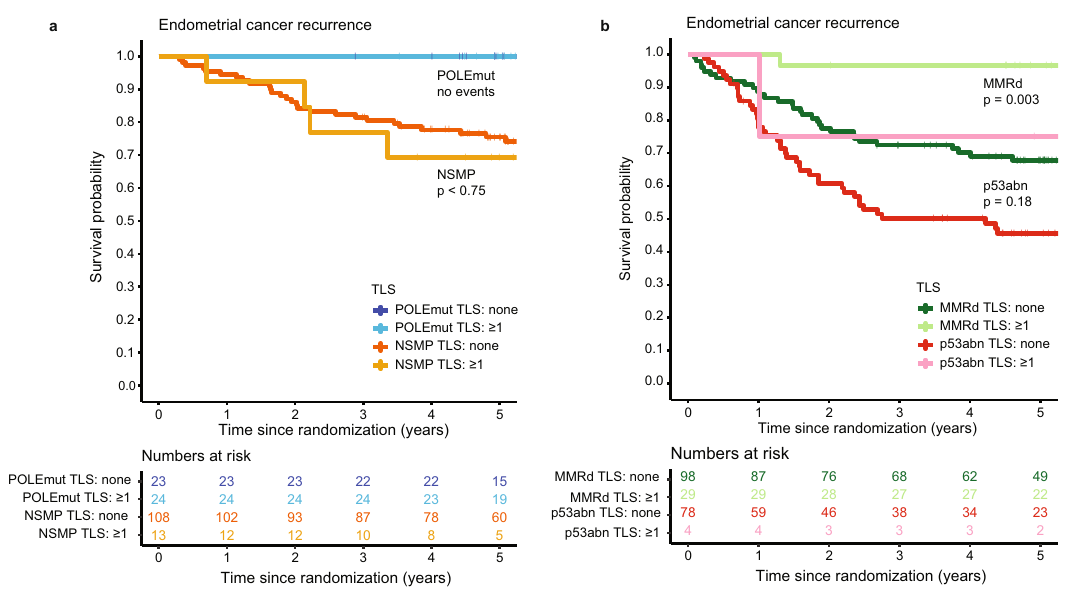
Fig. 6 Endometrial cancer recurrence by TLS presence across the endometrial cancer molecular classes. Endometrial cancer recurrence-free survival calculated according to Kaplan-Meier ’ s methodology and tested between patients with and without TLS using a two-sided log rank test (alpha 0.05). a Patients with POLE mut endometrial cancer ( N = 47) and MMRd endometrial cancer ( N = 127). b Patients with p53abn endometrial cancer ( N = 83) and NSMP endometrial cancer ( N = 121). TLS Tertiary lymphoid structure; POLE mut Pathogenic polymerase epsilon mutation; MMRd Mismatch repair de fi cient; p53abn p53 abnormal; NSMP No speci fi c molecular pro fi